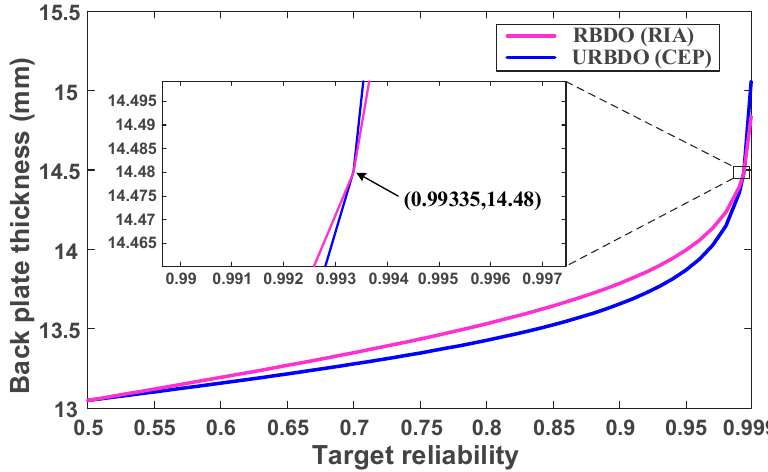
Figure 7. The comparative objective value of disc brakes under different reliability levels. The CEP method and the USGA algorithm are simultaneously applied to the brake disc system for the desired reliability level R U = 0.9987 to discuss the performance of two proposed approaches for solving the URBDO model. Parameters in the USGA algorithm are set as follows: Pop _ size = 30, P c = 0.8, P m = 0.2, and N = 12. In Figure 8, the iterative convergence process of back plate thickness h 3 generated by URBDO (CEP), URBDO (USGA), and RBDO (RIA) method for R U = 0.9987 is displayed. A detailed comparison of the optimal solutions of the three methods is summarized in Table 3. The number of function calls of constraint is expressed as F-evaluations. Furthermore, the CPU time is used to compare the efficiency of the CEP and USGA algorithms in processing the URBDO model.